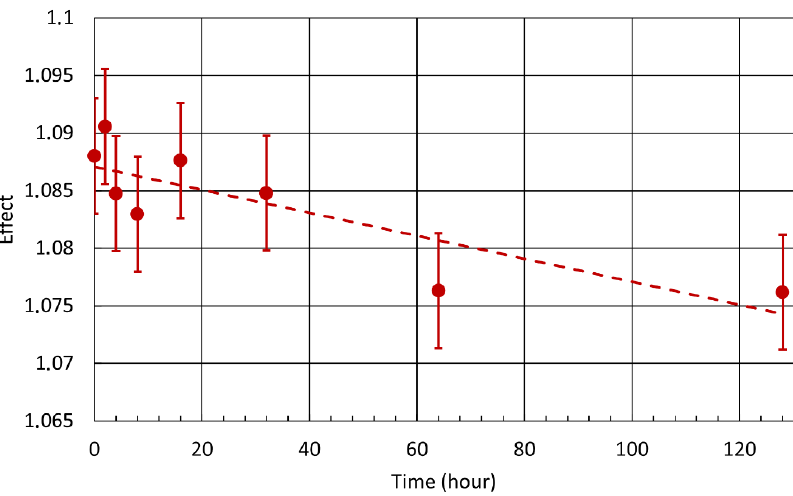
Figure 6. Effect in conversion X-ray Mössbauer spectroscopy in samples annealed at 550 °C.